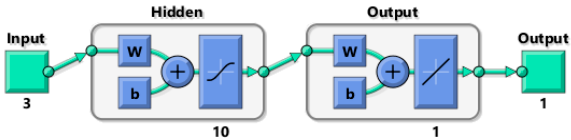
Figure 7. Structure of the shallow neural network.